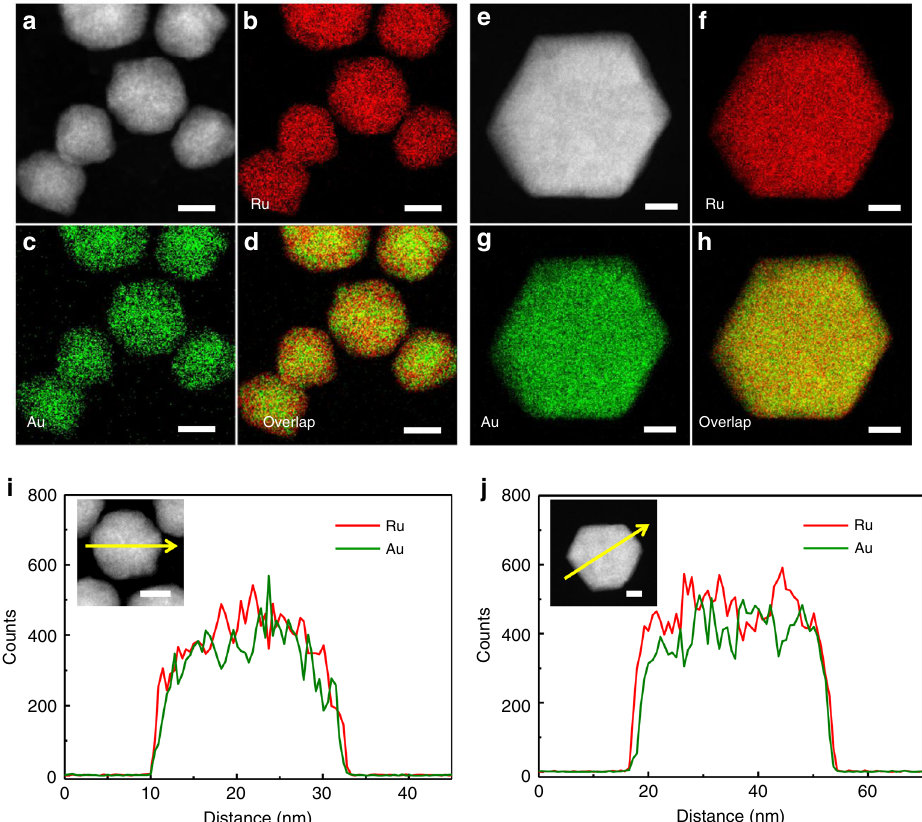
Fig. 1 EDX maps and line pro fi les of the synthesized AuRu 3 NPs. a HAADF-STEM image of fcc-AuRu 3 NPs. b Ru-L STEM − EDX map of ( a ). c Au-M STEM − EDX map of ( a ). d Overlay image of ( b ) and ( c ). e HAADF-STEM image of an hcp-AuRu 3 NP. f Ru-L STEM − EDX map of ( e ). g Au-M STEM − EDX map of ( e ). h Overlay image of ( f ) and ( g ). i , j EDX line pro fi les of an fcc-AuRu 3 NP and an hcp-AuRu 3 NP across the NPs along the arrows shown in the inset fi gure. Au and Ru are indicated as green and red lines, respectively. All of the scale bars shown in ( a – j ) are 10